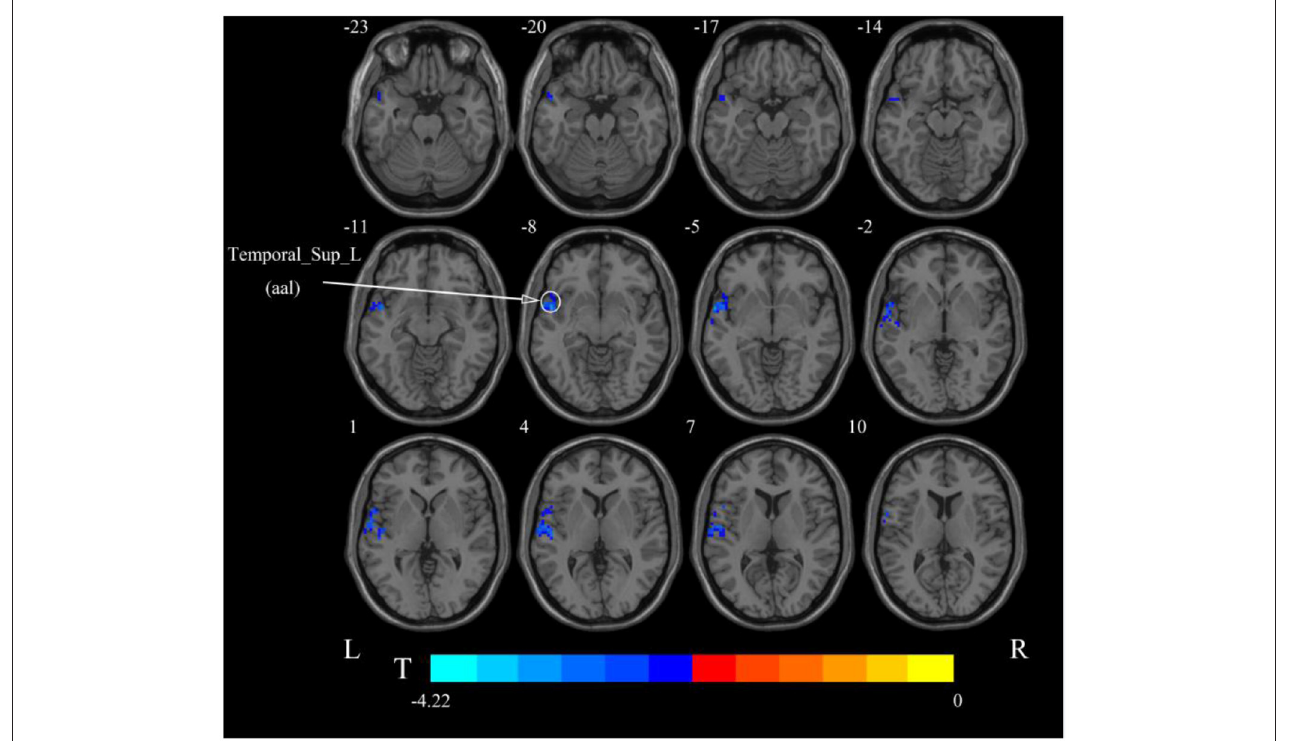
FIGURE 4 | Statistical maps showing ALFF change pre- and post-rTMS in the slow-4 band. Cool colors showing ALFF decreased after rTMS p < 0.05.